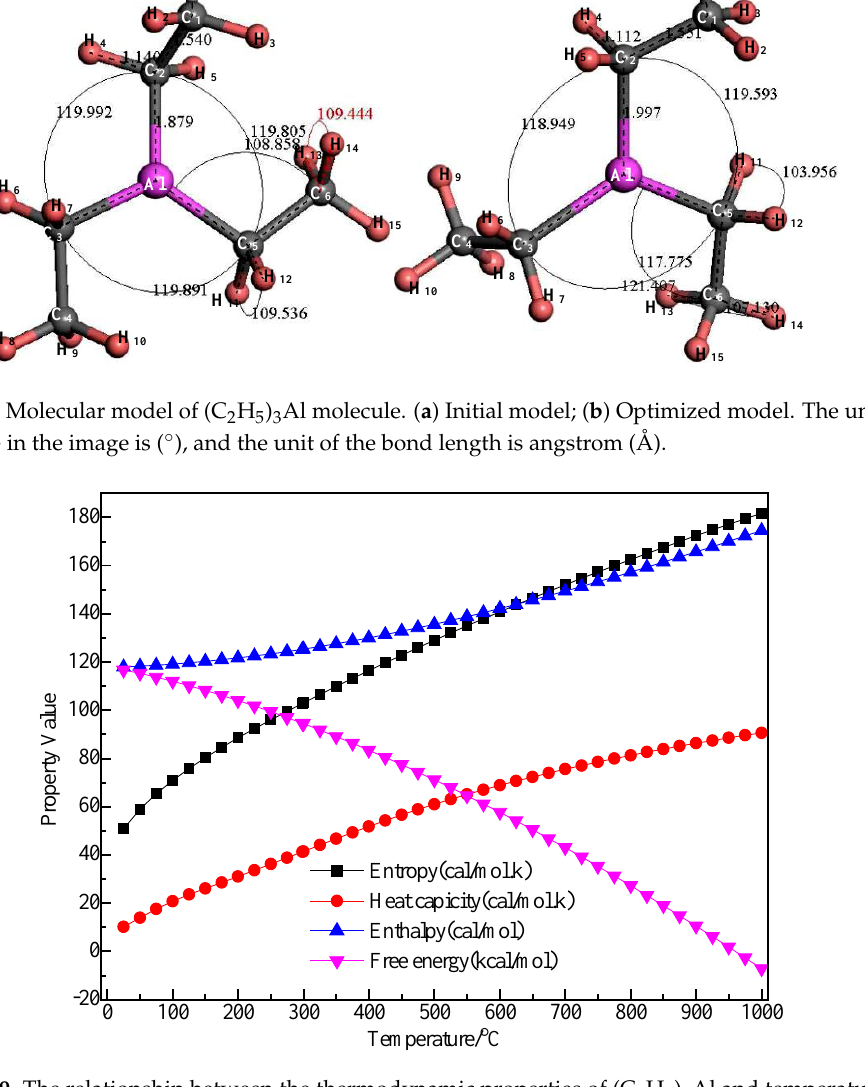
Figure 9. The relationship between the thermodynamic properties of (C 2 H 5 ) 3 Al and temperature.